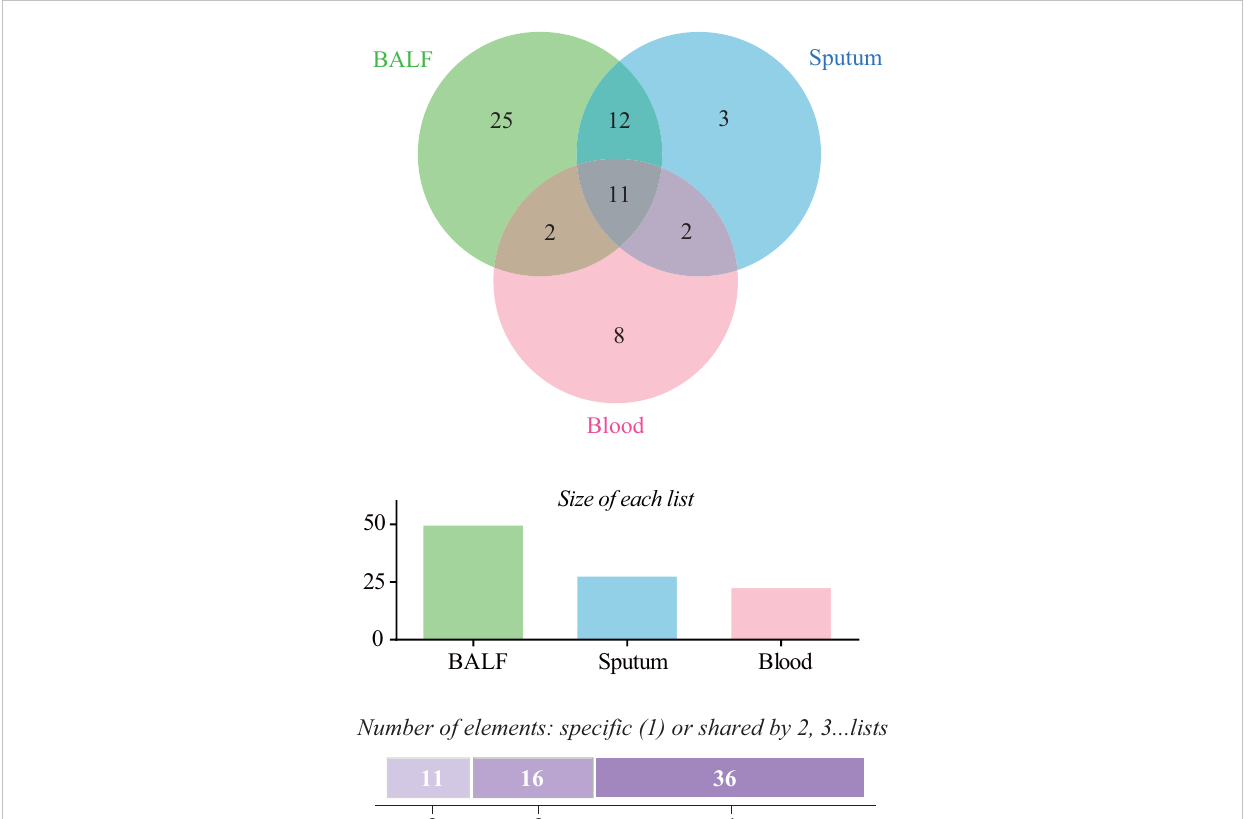
FIGURE 1 Comparison of pathogens detected by metagenomic next-generation sequencing (mNGS) among bronchoalveolar lavage fl uid (BALF), sputum, and blood